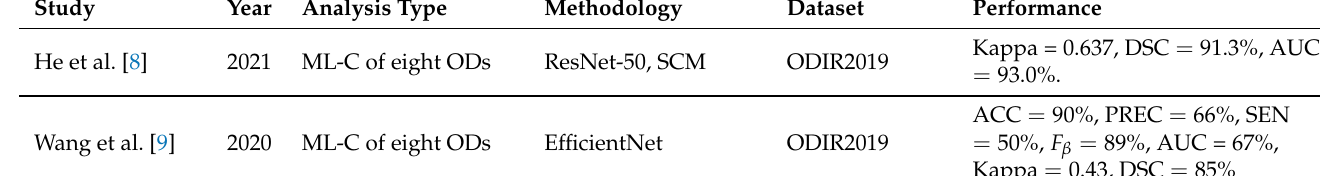
Table 2. A summary of some current studies from 2018 to 2021. AUC: area under curve, ACC: accu- racy, SPE: specificity, SEN: sensitivity, Kappa score, F β : F-Beta, and DSC: Dice similarity